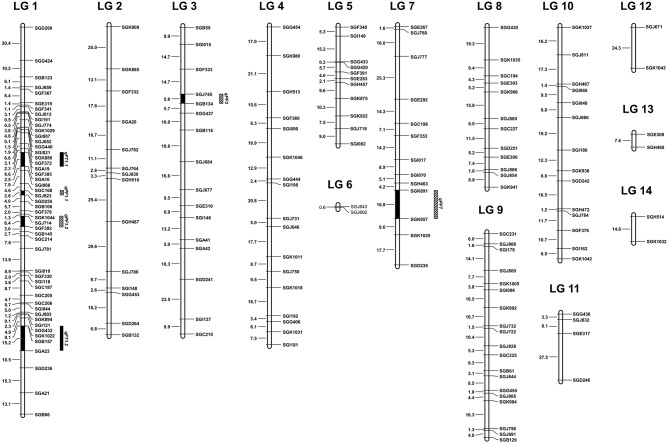
The 14 linkage groups (LG 1-LG 14) of sponge gourd base on the F2 population derived from the cross S1174 × P93075. The EST-SSR markers were shown on the right of the LG, and distances among markers were indicated in cM on the left. The QTLs for flowering time (qFT) were mapped to LG 1. The QTLs for pollen fertility (qPF) were mapped to LG 1, LG 3 and LG 7.